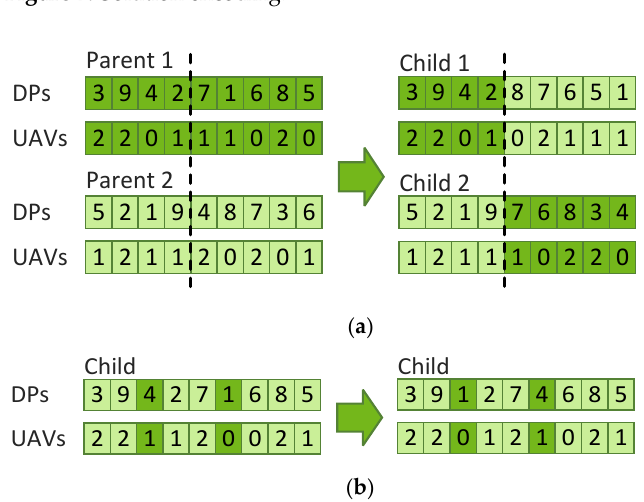
Figure 8. ( a ) Crossover operator and ( b ) mutation operator.